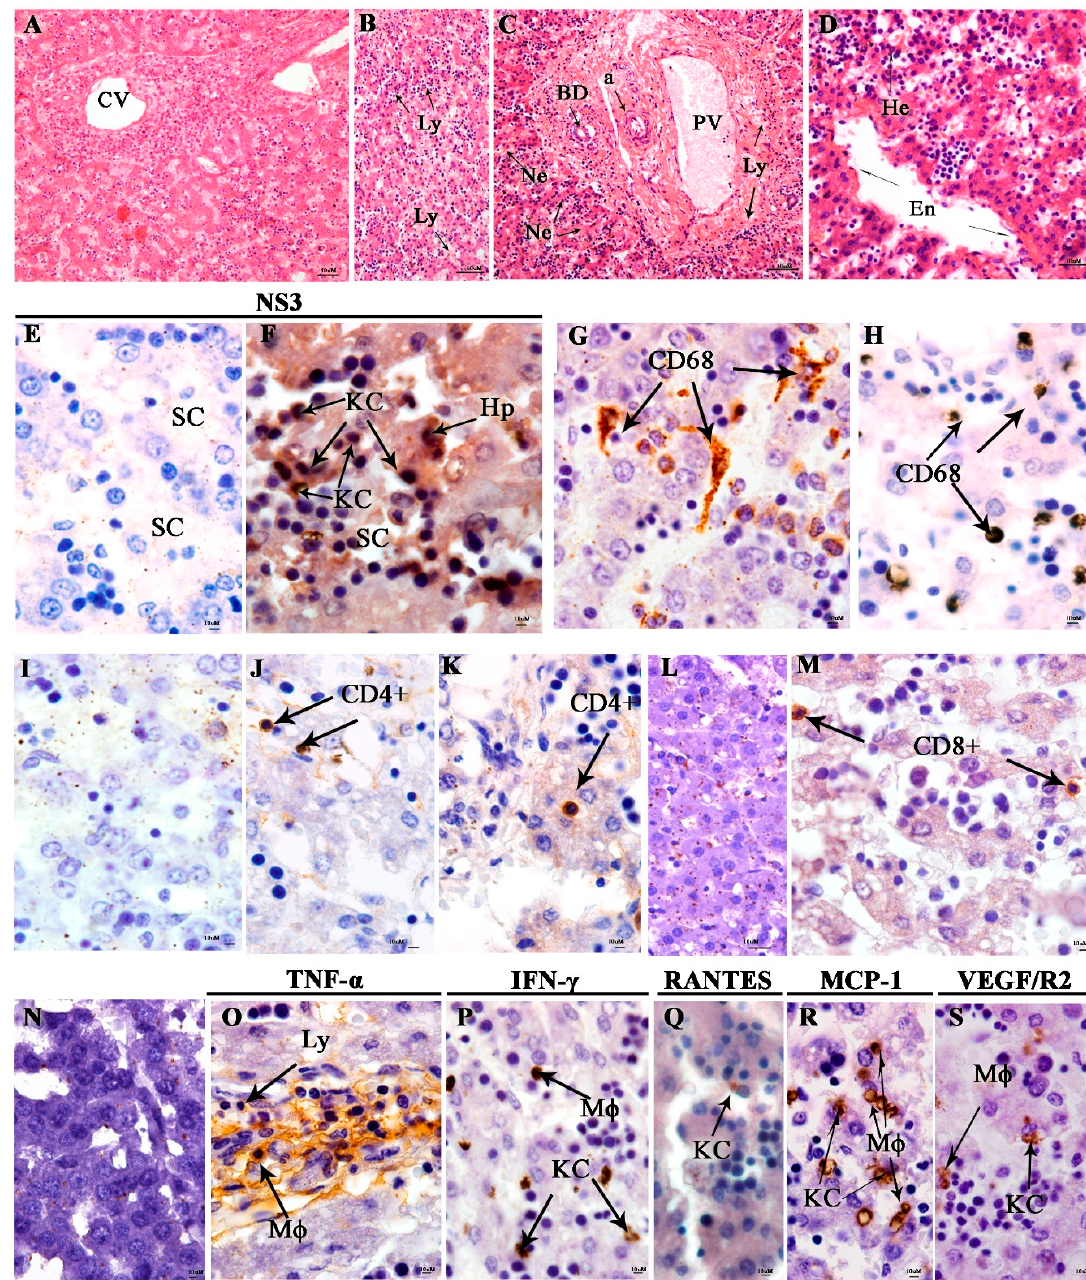
Figure 3. Histopathological and immunohistochemistry analysis of the liver. ( A ) Liver of a non-dengue case stained with HE, presenting a normal central vein (CV) aspect. Stillborn liver with lymphocytes infiltrate (Ly) in the lobular center ( B ), ( C ) area of necrotic hepatocytes (Ne), with normal bile duct (BD) and lymphocytes infiltrate (Ly) in the peri-portal vein (PV), ( D ) thickening of the endothelium (En) in the lobular center and presence of hemorrhage (He). ( E ) Sinusoids capillaries of the negative control without DENV NS3 staining. ( F ) DENV NS3 protein in Kupffer cells (HPC) and hepatocytes (Hp) near the sinusoids capillaries. CD68 cells staining in the control ( G ) and in the dengue case ( H ). No evidence of CD4 + ( I ) and CD8 + T cells ( L ) in the negative control. CD4 + ( J , K ) and CD8 + ( M ) T cells detection in the dengue case. ( N ) Representative negative control of cytokine and inflammatory mediators from a non-DENV case. ( O ) TNF- α expression in macrophages (Mø) and lymphocytes (Ly). ( P , R , S ) IFN- γ , MCP-1, and VEGF/R2 in macrophages (Mø) and Kupffer cells (HPC). ( Q ) RANTES expression in Kupffer cells (HPC).